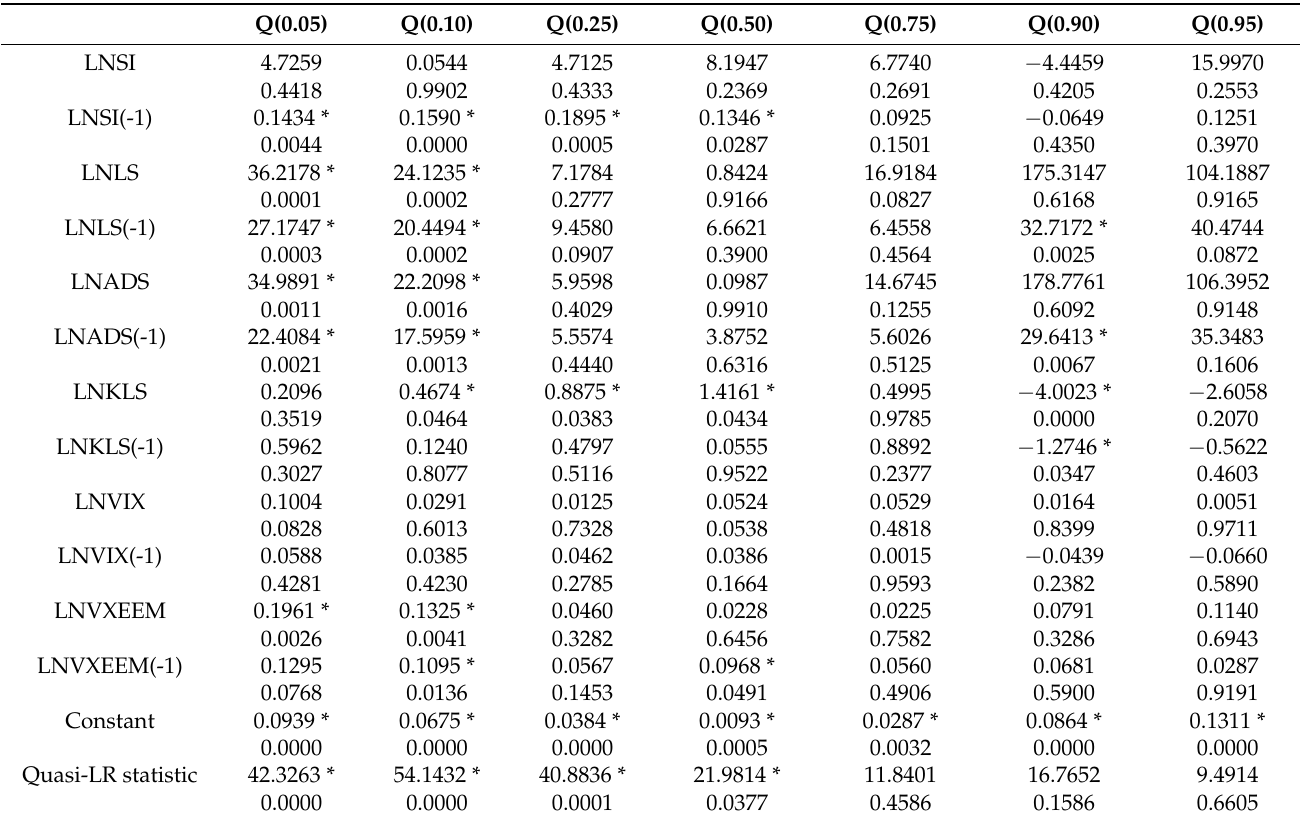
Table 2. Quantile regression estimates for the Sukuk index at different statistical significance